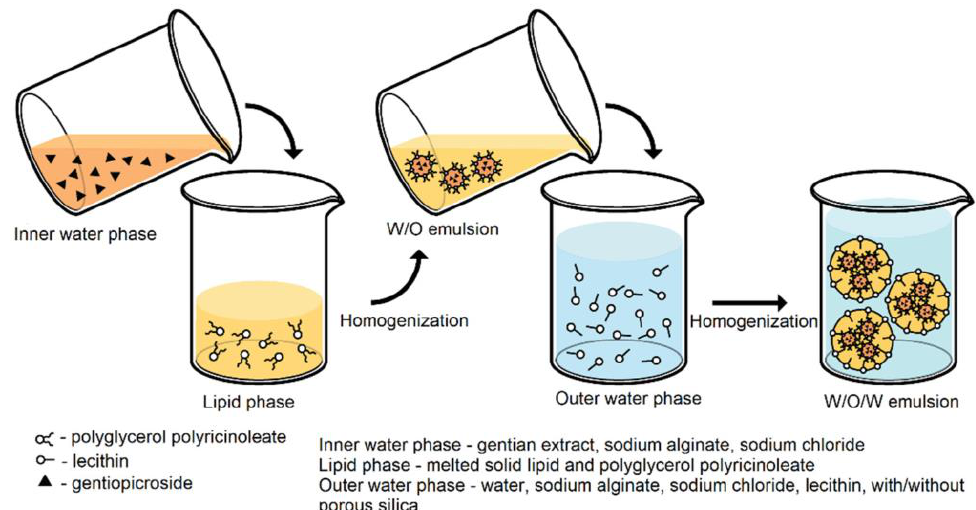
Figure 4. The preparation of SLNs by the double-emulsion method [104].